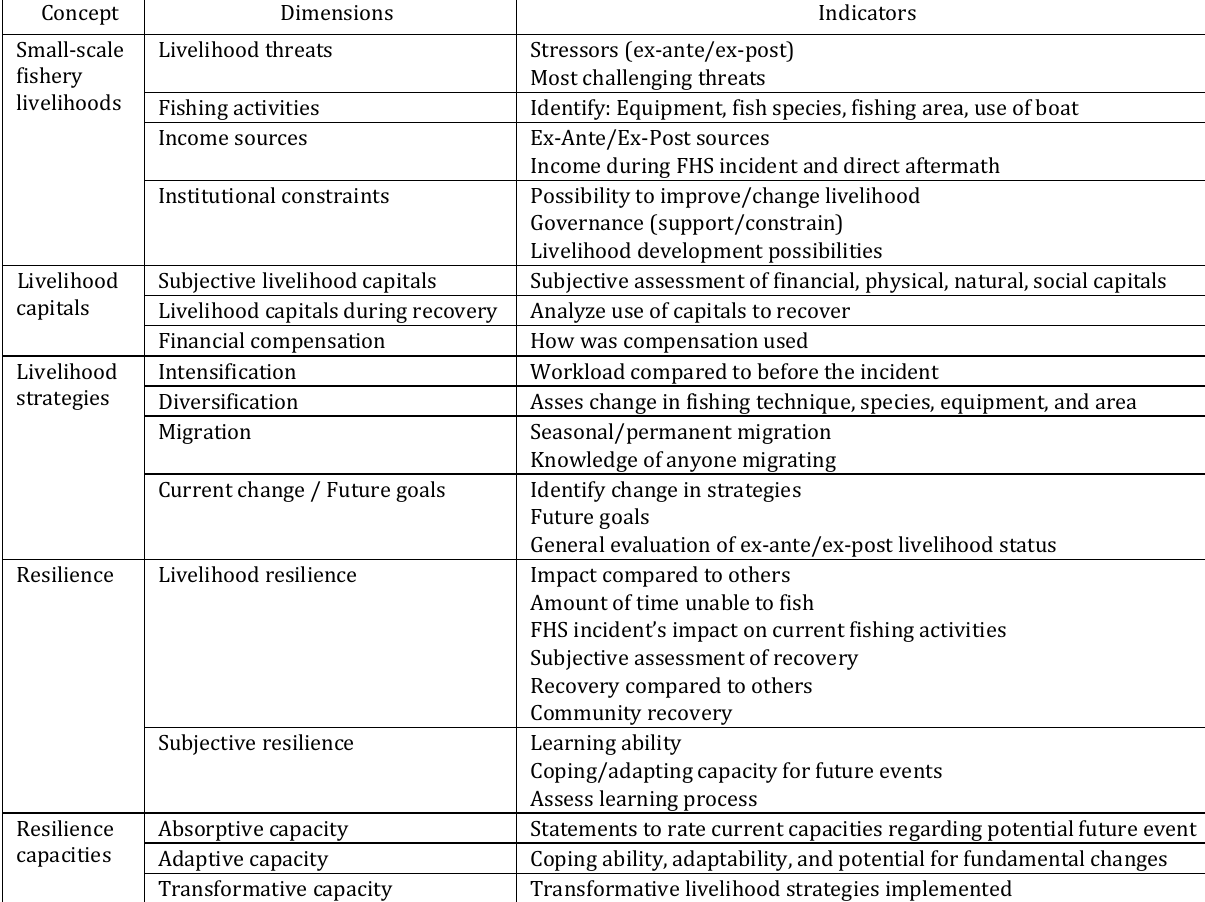
Table 1. Description of the main themes and measured indicators (own